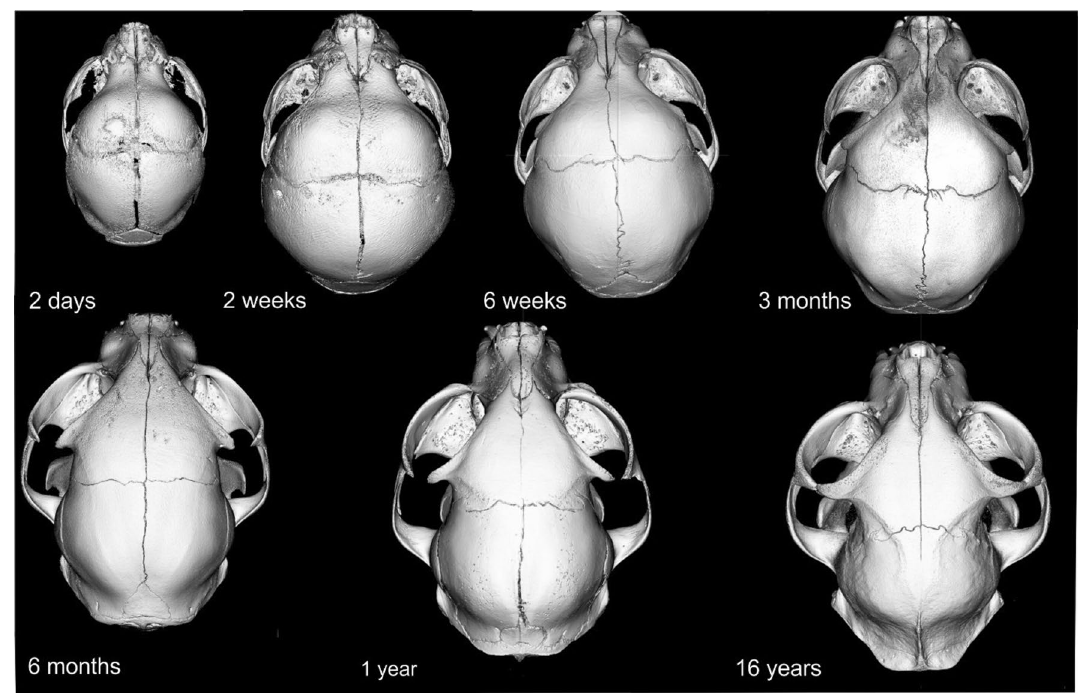
Figure 5. 3D models of a series of skull specimens based on micro-CT images of Domestic Shorthair cats at various ages in a dorsal